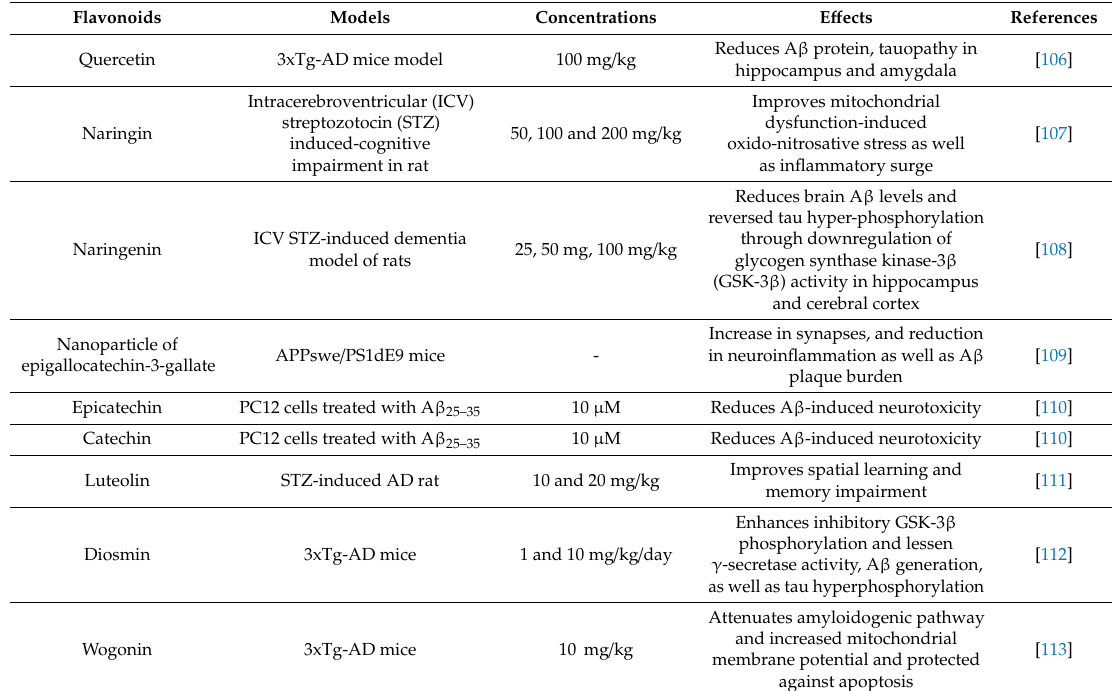
Table 2. Promising preclinical studies of flavonoids and their neuroprotective role against Alzheimer’s